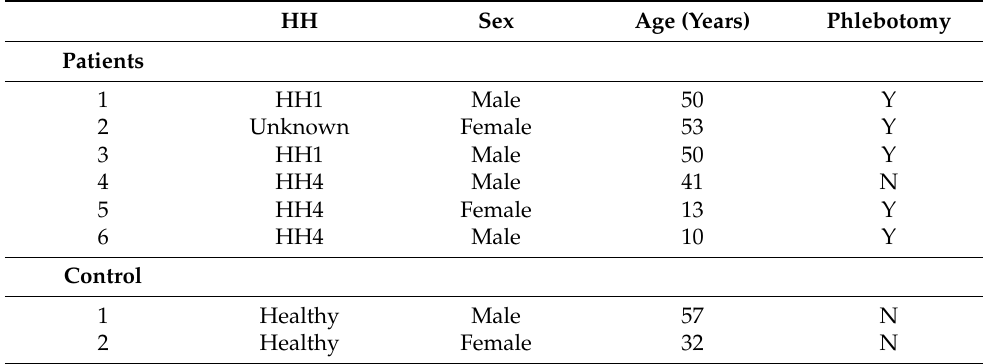
Table 3. Patient and control